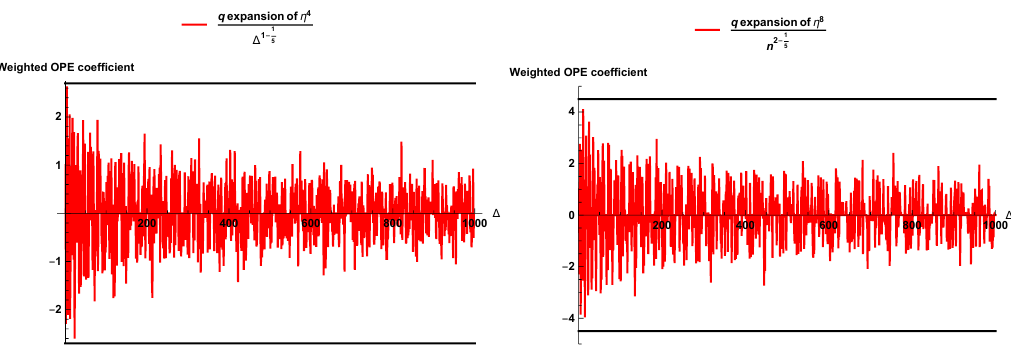
Figure 8 . The ratio of q expansion coe(cid:14)cient and (cid:1) (cid:1) O = 2 (cid:0) 1 = 5 as a function of (cid:1) is bounded by an order one number, denoted by the black lines.